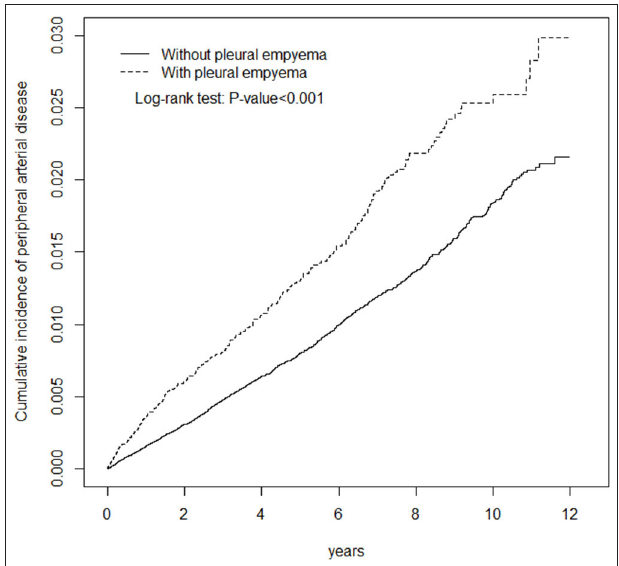
FIGURE 1 | Cumulative incidence of peripheral arterial disease in patients with pleural empyema and comparison patients.